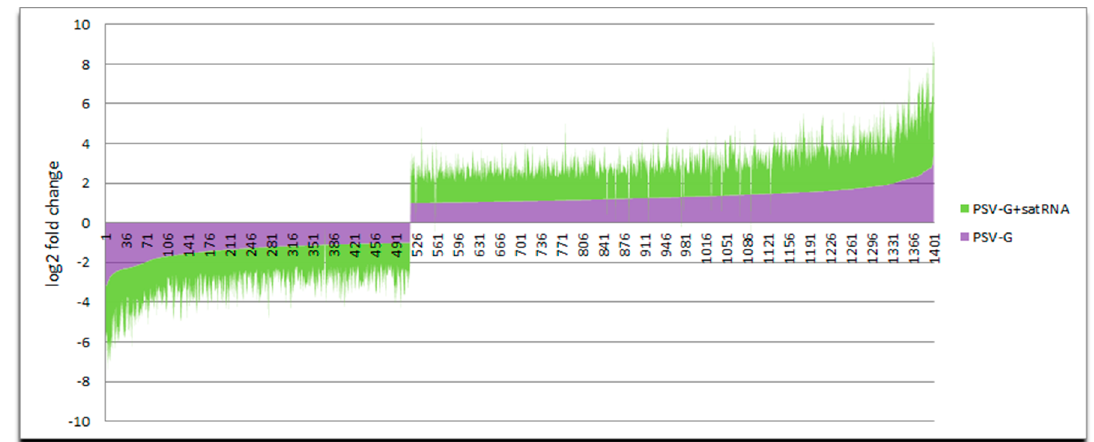
Figure 3. Levels of differentially expressed genes (DEGs) expressed in common by both PSV-G and PSV-G + satRNA are shown.